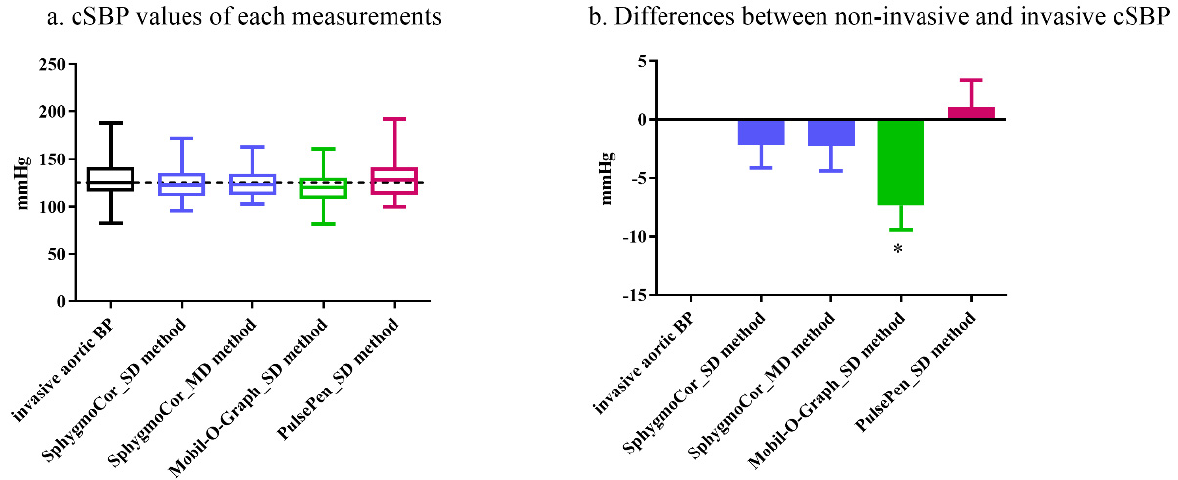
Figure 3. Central SBP values using different devices and calibration methods, and comparison with invasive measurements. Devices are shown in blue (SphygmoCor), green (Mobil-O-Graph), and red (PulsePen), separately. ( a ) the medium value, quartiles, maxima, and minima of inva-sive and noninvasive central SBP values using different devices and calibration methods. The dashed line indicates the medium of invasive aortic SBP value. ( b ) the difference between each noninvasive central SBP measurement and the invasive aortic SBP measurement (the invasive measurement was taken as reference “zero”). ANOVA with Bonferroni post hoc analysis was used to compare each noninvasive central SBP with the invasive aortic SBP. cSBP: central systolic blood pressure. SD: calibrated with the systolic/diastolic method. MD: calibrated with the mean/diastolic method. In our study, Mobil-O-Graph and PulsePen can only be calibrated with the systolic/dias-tolic blood pressure, thus it has only one group. *: p < 0.05.